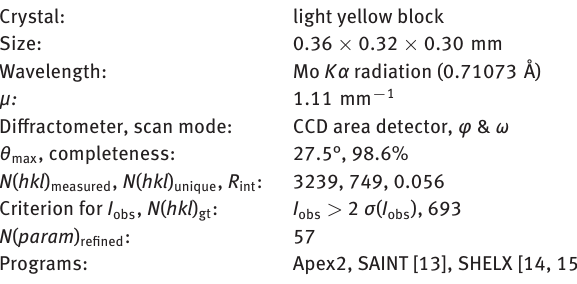
Table 1: Data collection and handling.